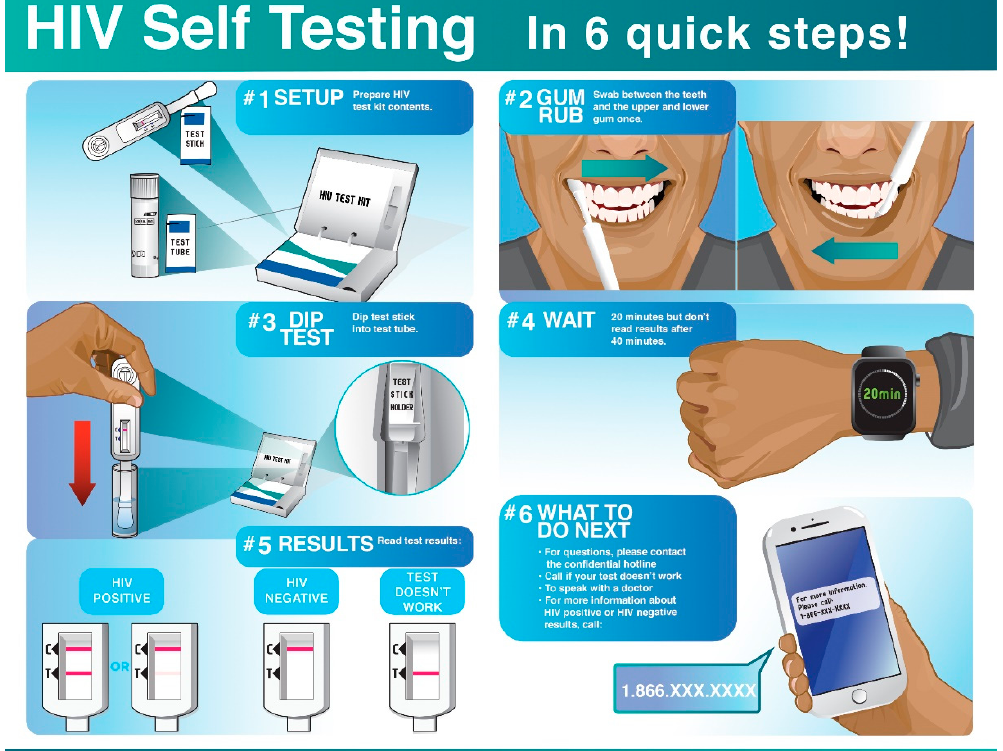
Figure 1. HIV self-testing infographic.